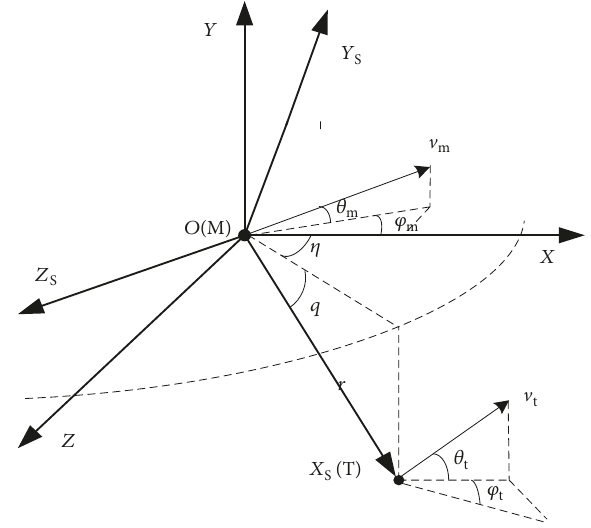
Figure 1: Three-dimensional missile–target geometry.